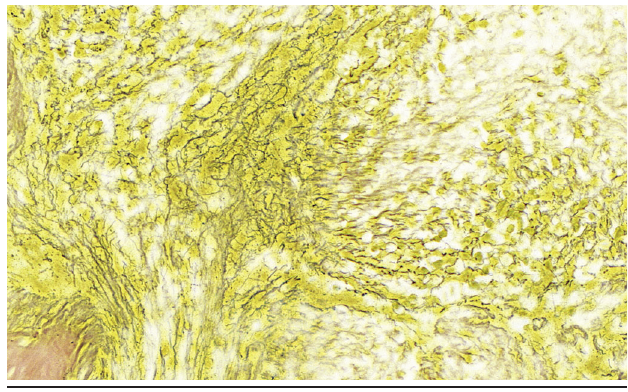
figurE 3 − Bone marrow biopsy (reticulin, 400×) Increased bone marrow reticulin with fibrosis foci.